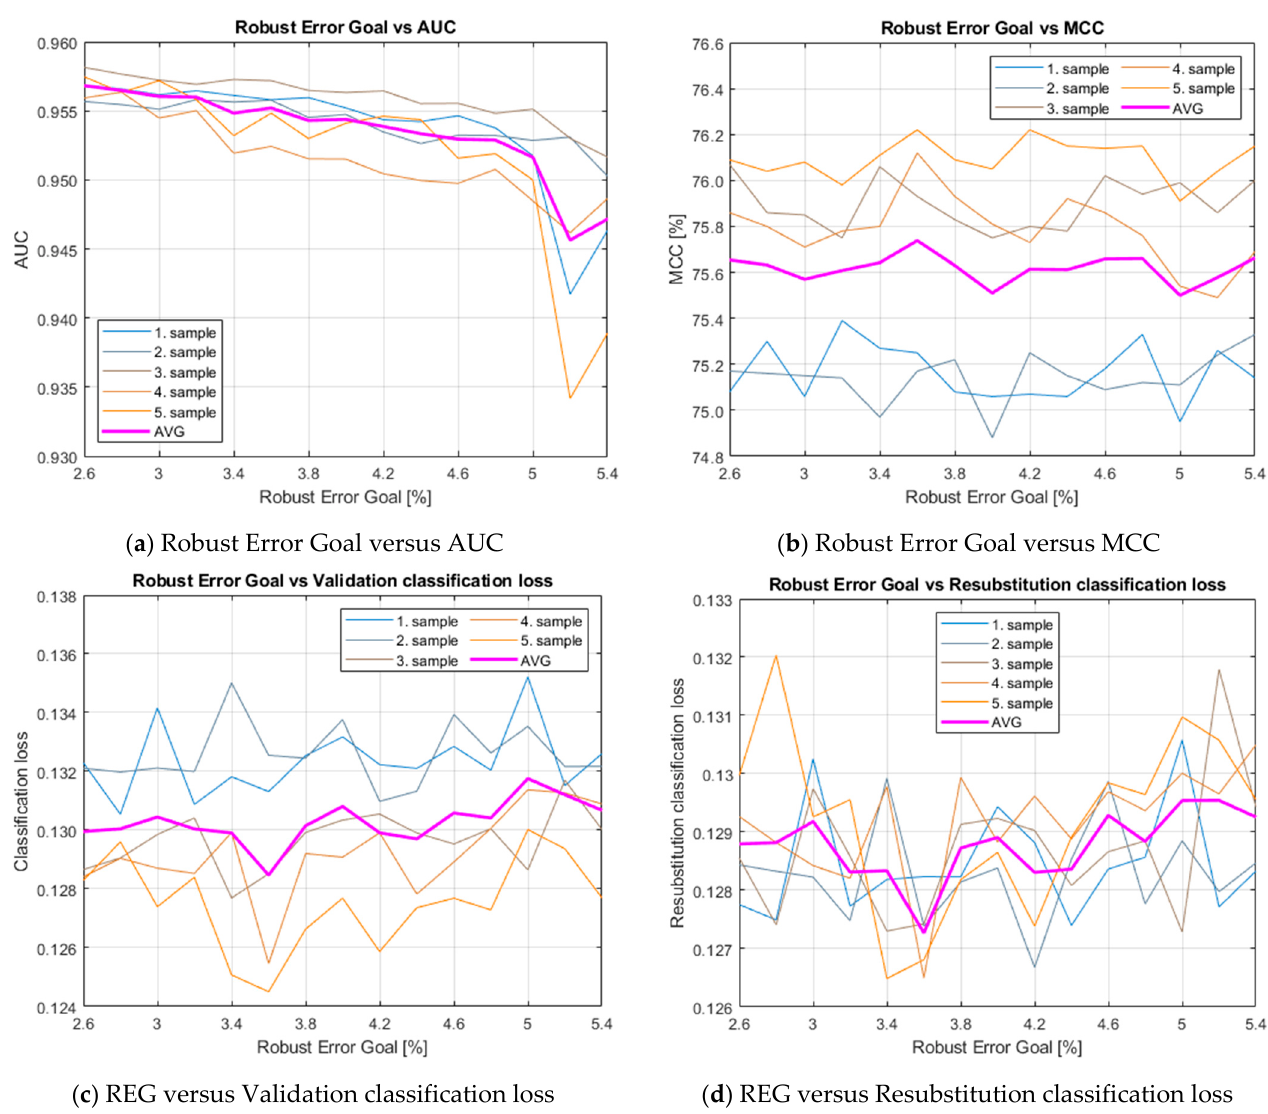
Figure 1. Summary of iteration of the Robust Error Goal parameter versus the performance metrics and classification loss in the RobustBoost element.